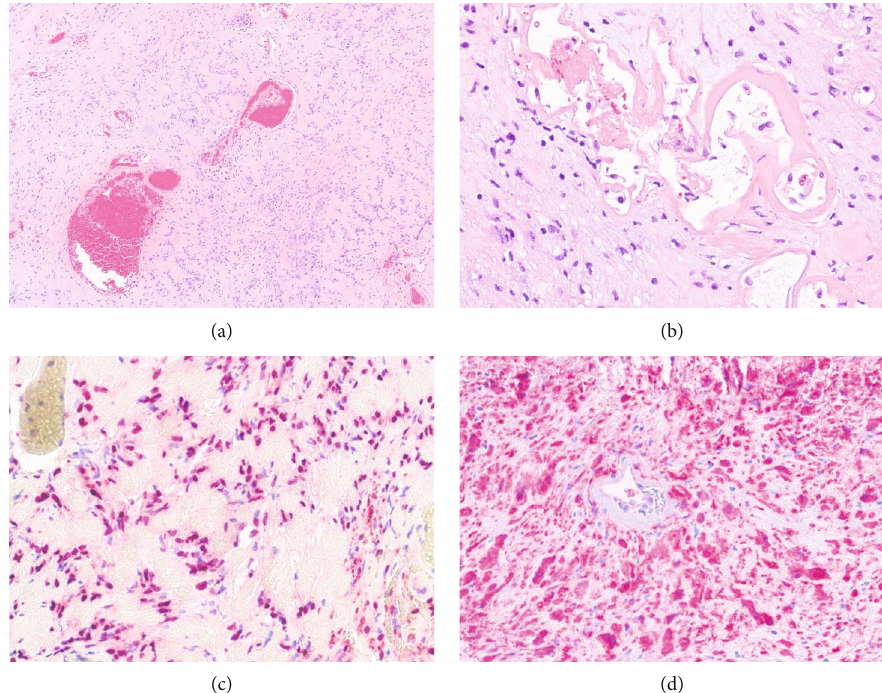
Figure 1: (a) Low-power examination reveals Schwannian cells arranged in loose fascicles, surrounded by eosinophilic stroma with Verocay bodies (40x). (b) Higher power examination shows the bland Schwannian cells set in a loose collagenous stroma with hyalinized vessels (200x). Schwannian cells are positive for (c) SOX-10 (200x) and (d) S100 (200x).